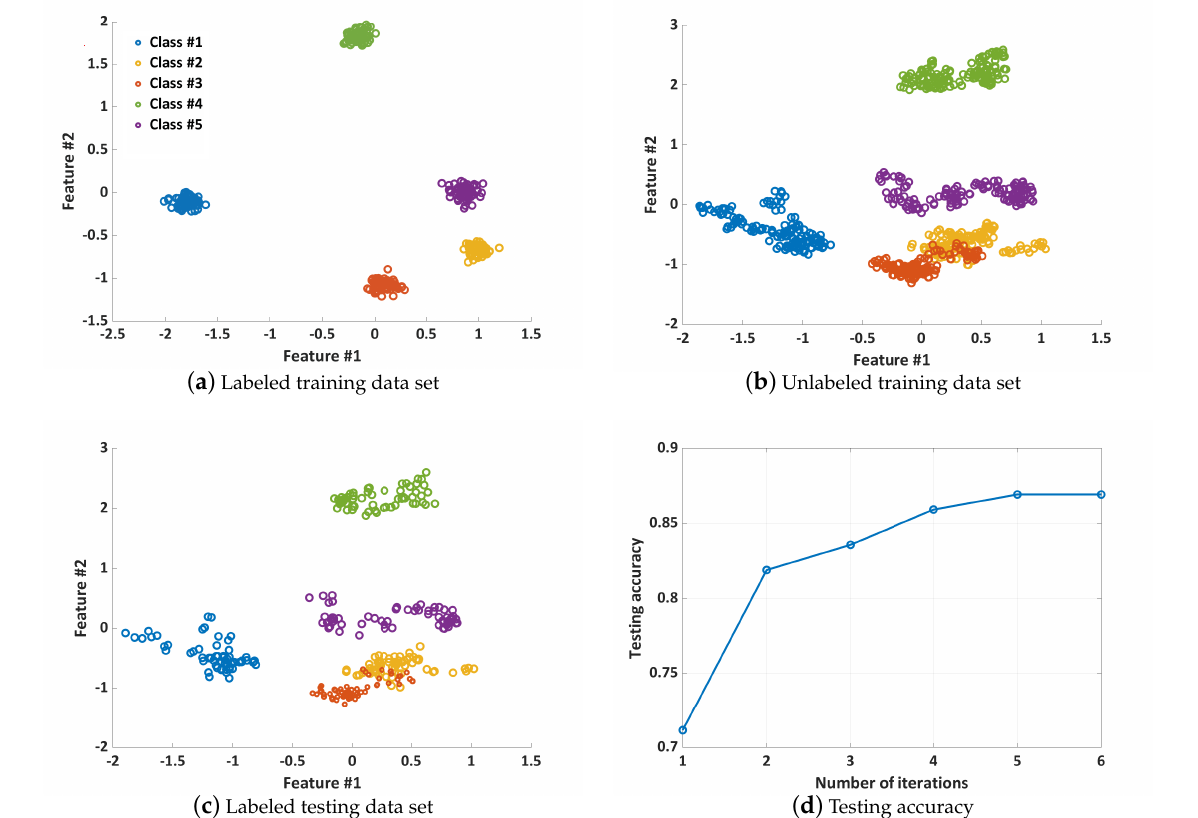
Figure 2. The synthetic data set generated with the make_blobs package.